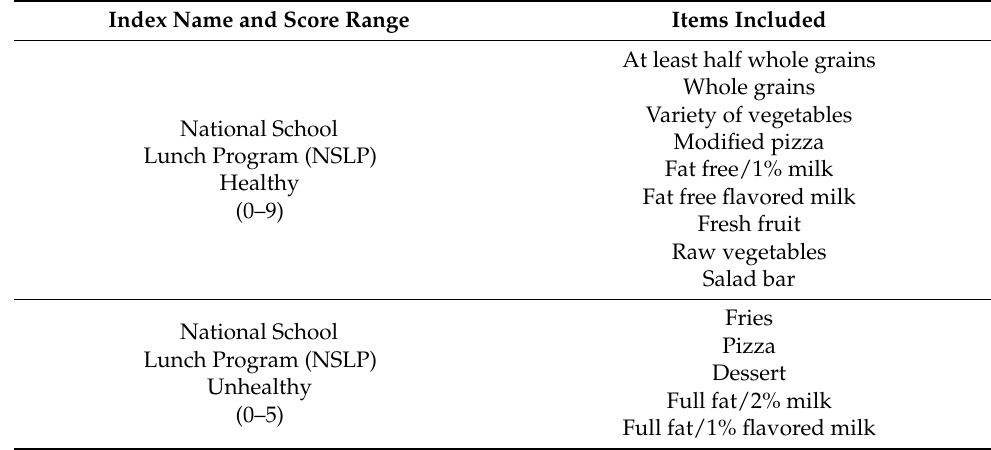
Table 1. List of items included in indices capturing the food environment in the National School Lunch Program (NSLP) in K-12